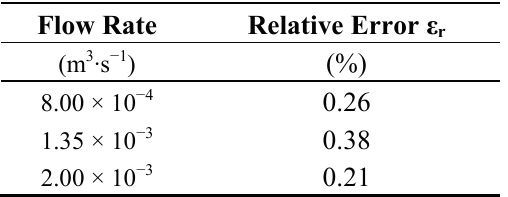
Table 6. Relative error of MEMS